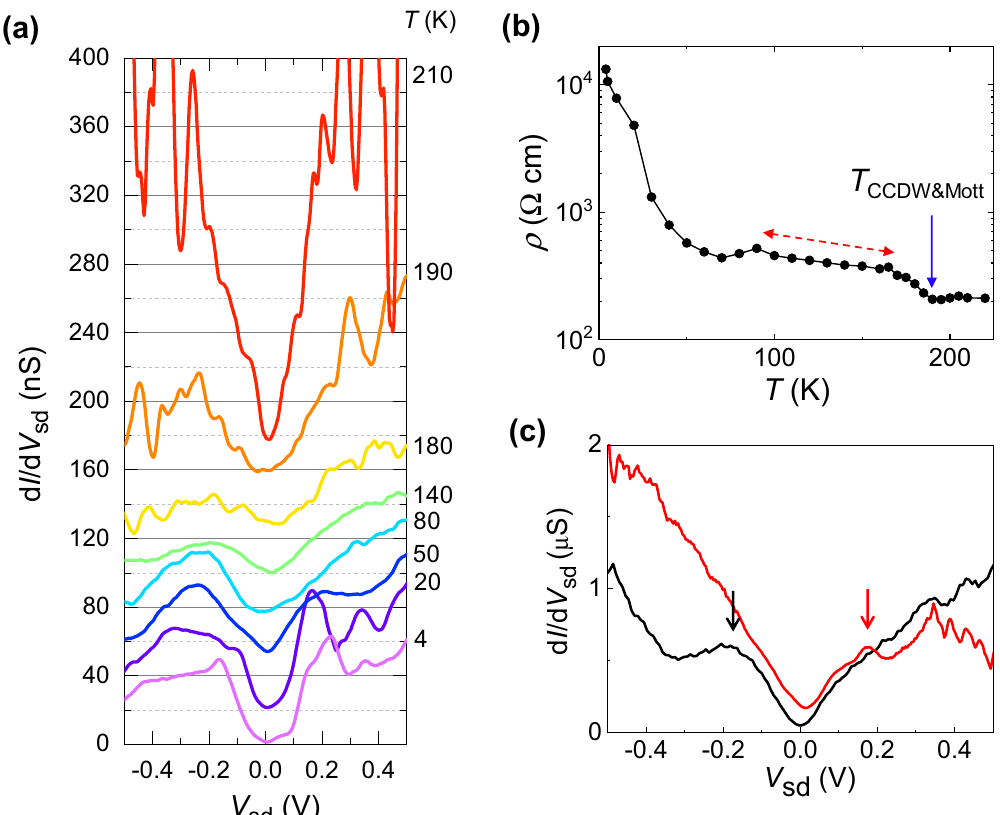
Figure 3. Temperature dependence of Mott gap. ( a ) d I /d V sd as a function of V sd at V g = 30 V for various temperatures, where each curve is vertically shifted for clarity. ( b ) Zero-bias resistivity at V sd = 0 V as a function of T , as obtained from ( a ). Near T ~ 180 K, the resistivity suddenly increased with decreasing T , as indicated by the arrow. The region indicated by a dashed bidirectional arrow indicates a pseudogap region. ( c ) d I /d V sd as a function of V sd for two other 1 T -TaS 2 devices, each of which showed a gap feature, as indicated by the two